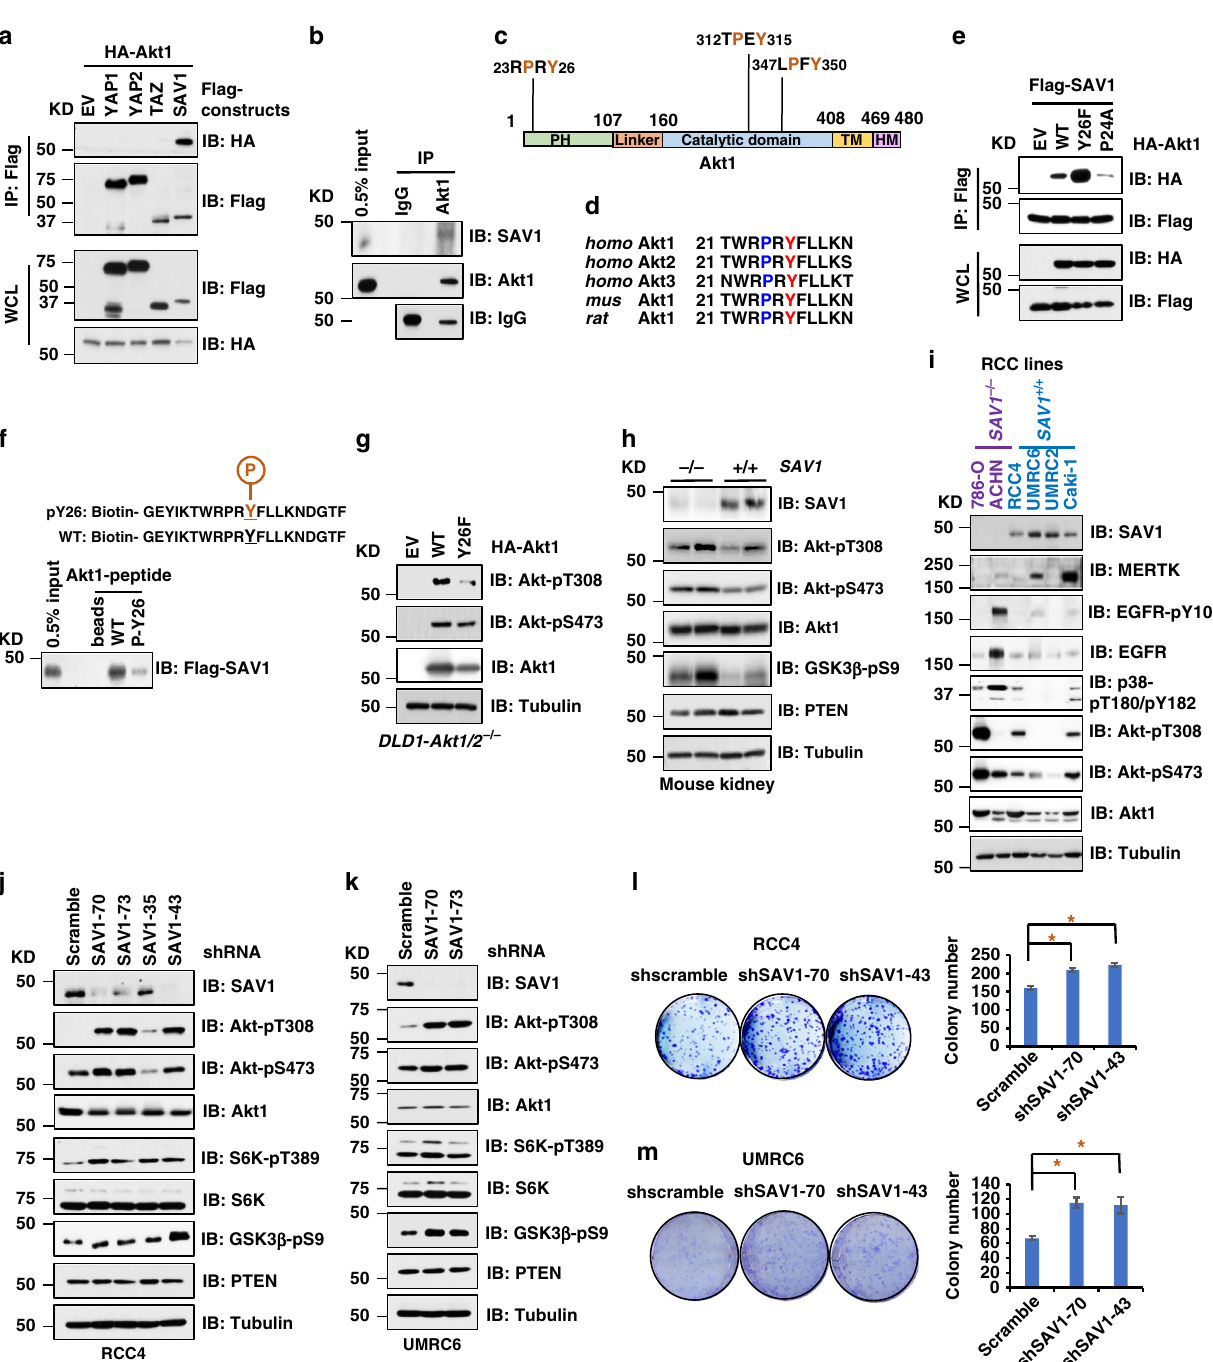
Fig. 1 SAV1 binds and suppresses Akt activity. a Immunoblot (IB) analysis of whole cell lysates (WCL) and Flag-immunoprecipitates (IP) derived from HEK293 cells transfected with indicated DNA constructs. b IB analysis of WCL and endogenous Akt1-IP derived from RCC4 cells. c A cartoon illustration of the distribution of PxY motifs in Akt1. d Protein sequence alignment the "PxY" motif located in the PH domain of Akt isoforms. e IB analysis of WCL and Flag-IP derived from HEK293 cells transfected with indicated DNA constructs. f IB analysis of indicated Akt1 peptide pulldown products. g IB analysis of WCL derived from DLD1 - Akt1/2 − / − cells transfected with indicated HA-Akt1 constructs. h IB analysis of WCL derived from WT and SAV1 − / − mouse kidney tissues. i IB analysis of WCL derived from indicated RCC lines. j , k RCC4 ( j ) and UMRC6 ( k ) cells were depleted of endogenous SAV1 by lentiviral shRNAs against SAV1 and harvested 72-h post puromycin selection (1 μ g/ml) for IB analysis. l , m 600 cells resulted from ( j ) and ( k ) were subjected to colony formation